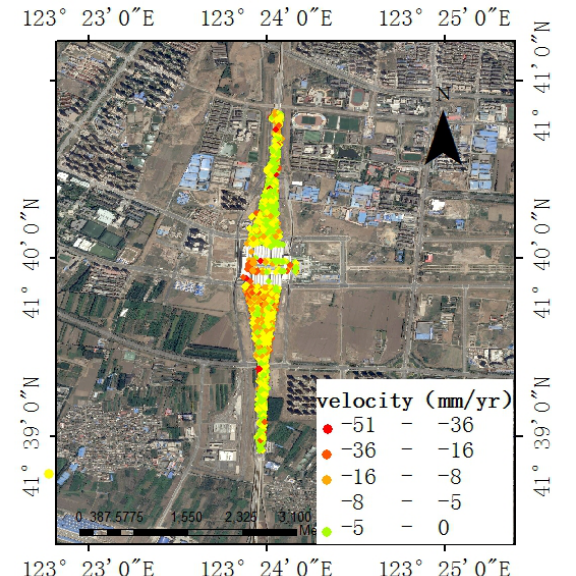
Figure.2(a) Overall deformation pattern from the western stack